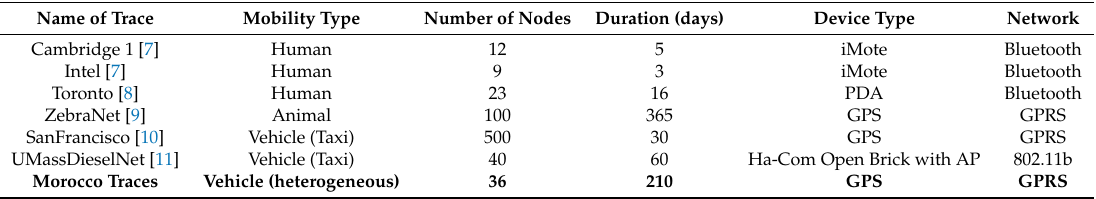
Table 2. Comparative summary of previous trace models and Morocco